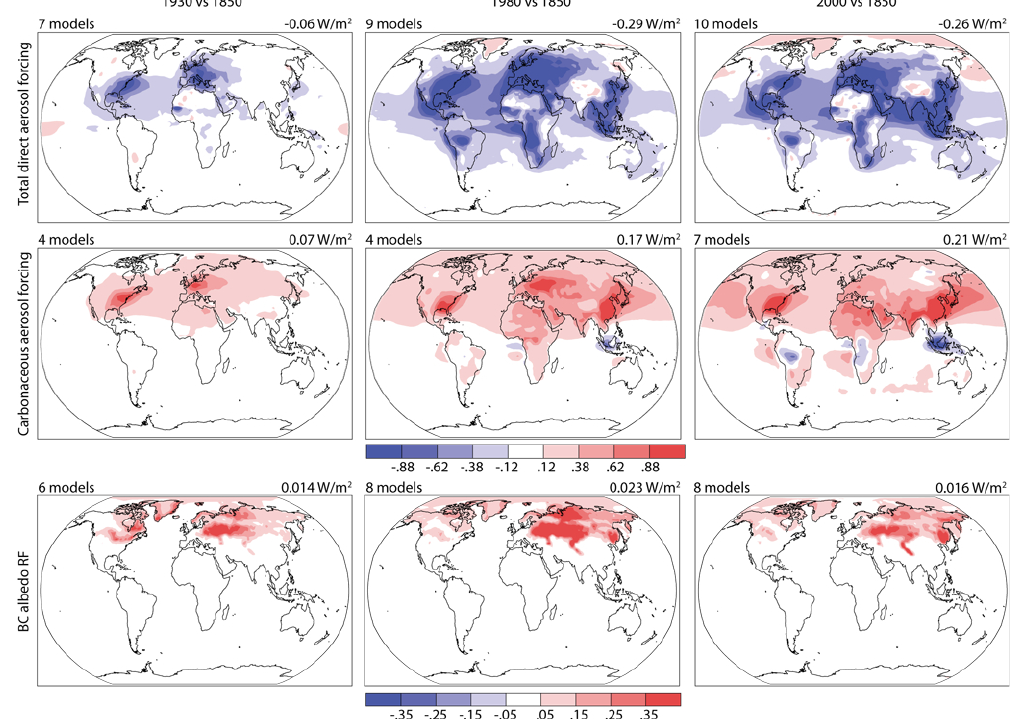
Fig. 12. Multi-model mean all aerosol RF, carbonaceous aerosol RF and BC albedo RF for 1930, 1980 and 2000 (all relative to 1850; Wm − 2 ) . The mean 2000 carbonaceous forcing in the 4 models with results at earlier times is also 0.21Wm − 2 . Mean total 2000 direct forcing in the 7 models with results for 1930 and in the 9 models with results for 1980 is also − 0.26Wm − 2